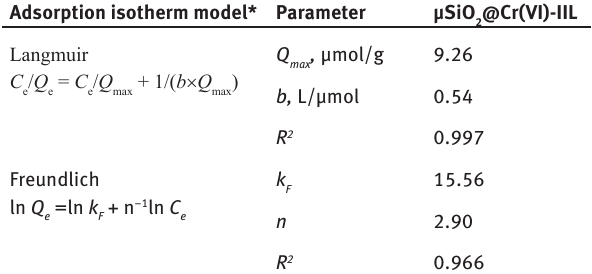
Table 3: Adsorption parameters of the Langmuir and Freundlich isotherm models for adsorption of Cr(VI) ions onto the µSiO Cr(VI)-IIL at temperature